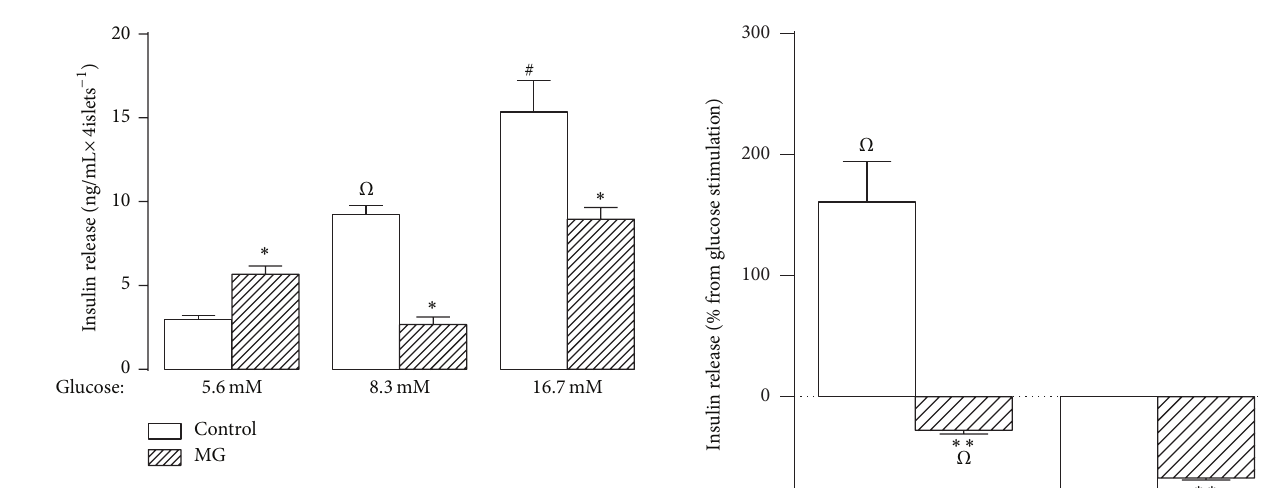
Figure 1: Glucose-stimulated insulin secretion (GSIS). Insulino- tropic effect of GSIS from isolated pancreatic islets in absence or presence of methylglyoxal. Insulin secretion was stimulated by increasing concentrations of glucose, as indicated below the 𝑥 -axis. Bars represent the mean ± S.E.M. ∗ 𝑃 < 0.01 compared with the respective control group; Ω 𝑃 < 0.01 compared with 5.6 or 16.7 mM of glucose; # 𝑃 < 0.01 compared with 5.6 or 8.3 mM of glucose.